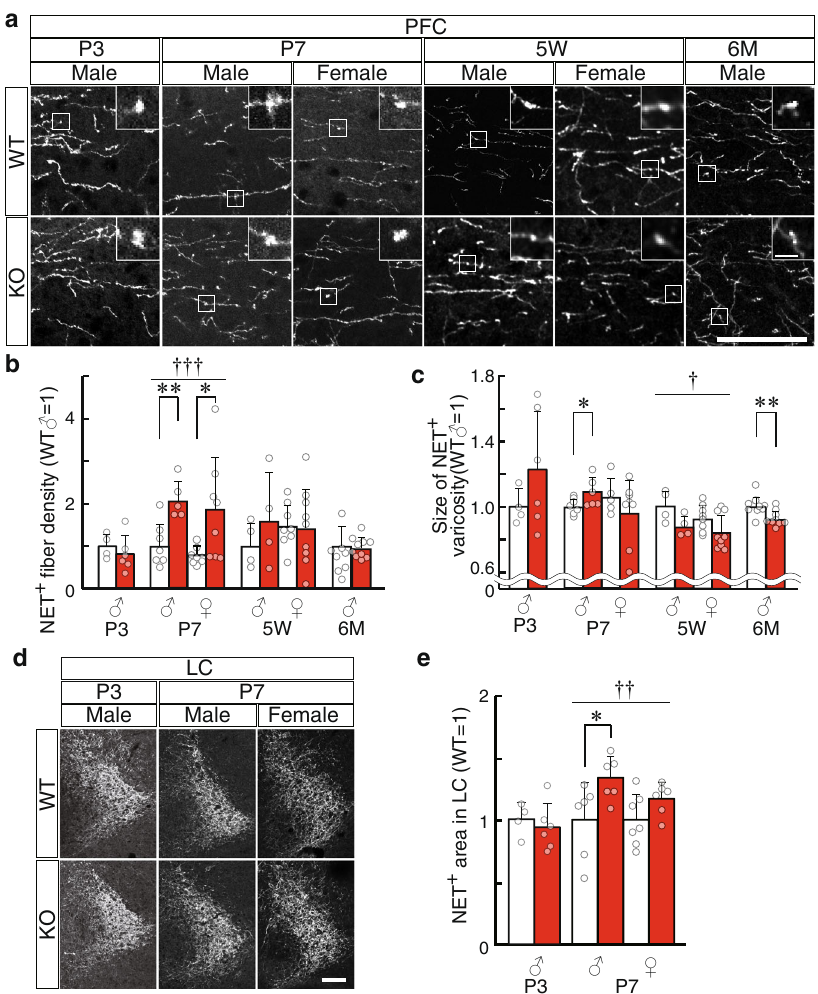
Fig. 2 Postnatal noradrenergic fi ber development and monoamine levels in the brains of Slitrk1-KO mice. Brain sections obtained from 3 days-old (P3), 7 days-old (P7), 5 weeks-old (5W), or 6 months old (6M) mice were immunostained using an anti-NET antibody. a Representative image for PFC. Insets indicate the enlarged views of the varicosities in the boxed region. Scale bar , 50 µ m; 5 µ m (inset). b NET + fi ber density in the PFC. The mean value of male WT mice was de fi ned as 1. c Size of NET + varicosity. The mean value of male WT mice was de fi ned as 1. Absolute values of the male WT varicosity size in µ m 2 : P3, 0.90; P7, 077; 5W, 1.33; 6M, 1.02. b , c WT male, n = 4, 7, 4, 9; KO male, n = 6, 5, 4, 9 at P3, P7, 5W, 6M, respectively; WT female, n = 8, 8; KO female, n = 8, 9 at P7, 5 W respectively. d Representative images for LC. Scale bar , 100 µ m. e NET + area in the LC. The mean value of WT mice was de fi ned as 1. Absolute values of the male WT varicosity size in µ m 2 : P3, 1.3 × 10 4 ; P7 male, 8.9 × 10 3 ; P7 female = 1.2 × 10 4 µ m 2 . WT male, n = 4, 6; KO male, n = 6, 6 at P3, P7, respectively. WT female, n = 7; KO female, n = 6 at P7. b , c , e Open bar , WT; red bar , KO. Data were presented as mean ± SD. * P <